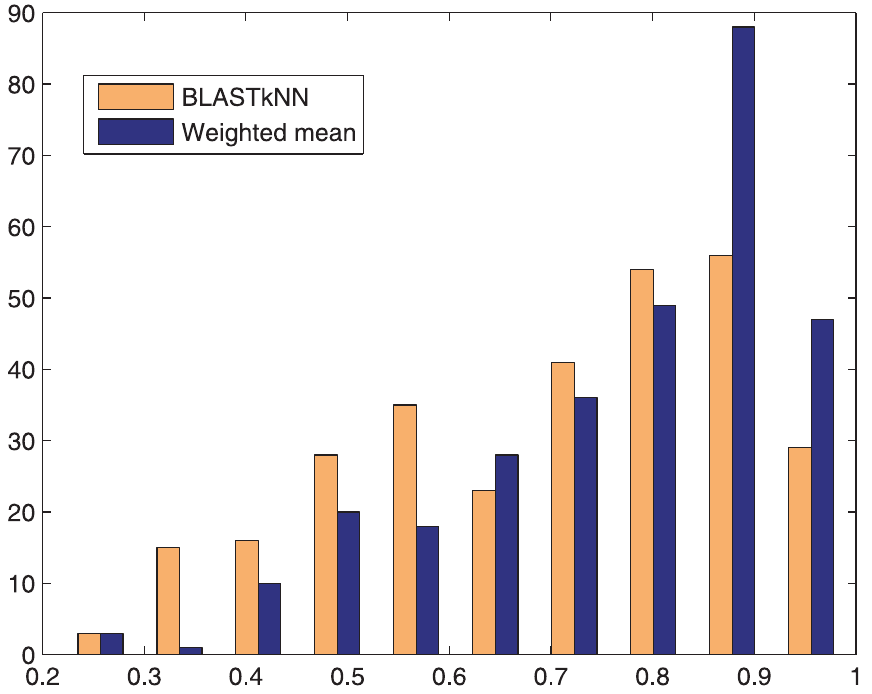
Figure 2. Histogram of F 1 scores of BLAST- k NN and Weighted Mean methods for 300 GO terms.